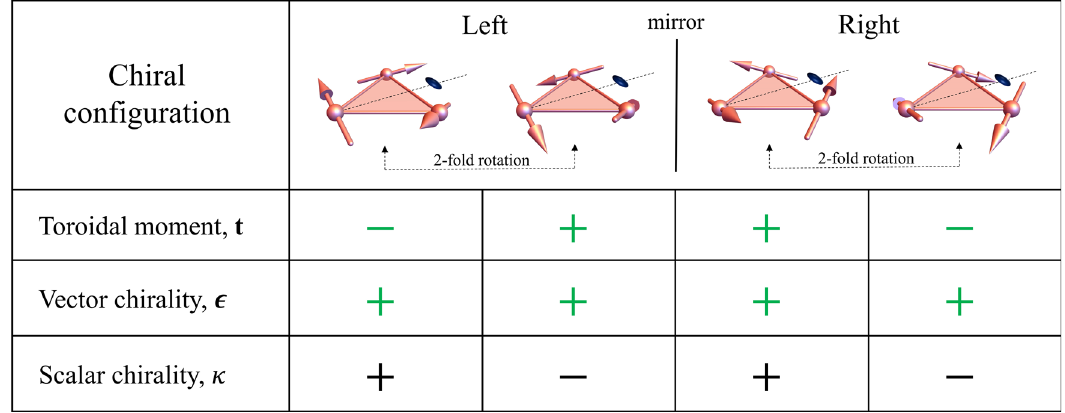
Fig. 1 Toroidal moment and magnetic chirality of spin vortex con fi gurations with 3-fold rotation symmetry. Four chiral noncoplanar structures are divided into groups of two left-handed ones and two right-handed ones. Those within each group are connected by 2-fold rotations and those between two groups by a mirror operation. The spins (axial vector) are represented as arrows. The dashed line with an ellipsoid indicates one of the three 2-fold axes. Three relevant physical quantities are de fi ned with spins { S i = 1, 2, 3} numbered anticlockwise: toroidal moment t = ∑ i r i × S i , where r i is the vector from the center of the triangle to spin S i ; vector chirality ϵ = S 1 × S 2 + S 2 × S 3 + S 3 × S 1 ; scalar chirality κ = ( S 1 × S 2 ) ⋅ S 3 . Green symbols + and − for a toroidal moment and vector chirality denote the direction of these quantities with respect to the net magnetic moment, + for parallel and − for antiparallel. The magnetic vector chirality characterizes the sense of spin rotation along an oriented loop (or line), while the toroidal moment is associated with that around a center. Scalar spin chirality is a measure of non-coplanarity that does not necessarily have a sense of rotation. In the current example, toroidal moment and scalar chirality have a one-to-one correspondence to the net magnetic moment for a given handedness, since all of them are odd under time reversal. In a crystalline material with these chiral spin trimers as basic units, a ferro alignment of net magnetic moments of trimers will lead to a ferro ordering of toroidal moments and scalar